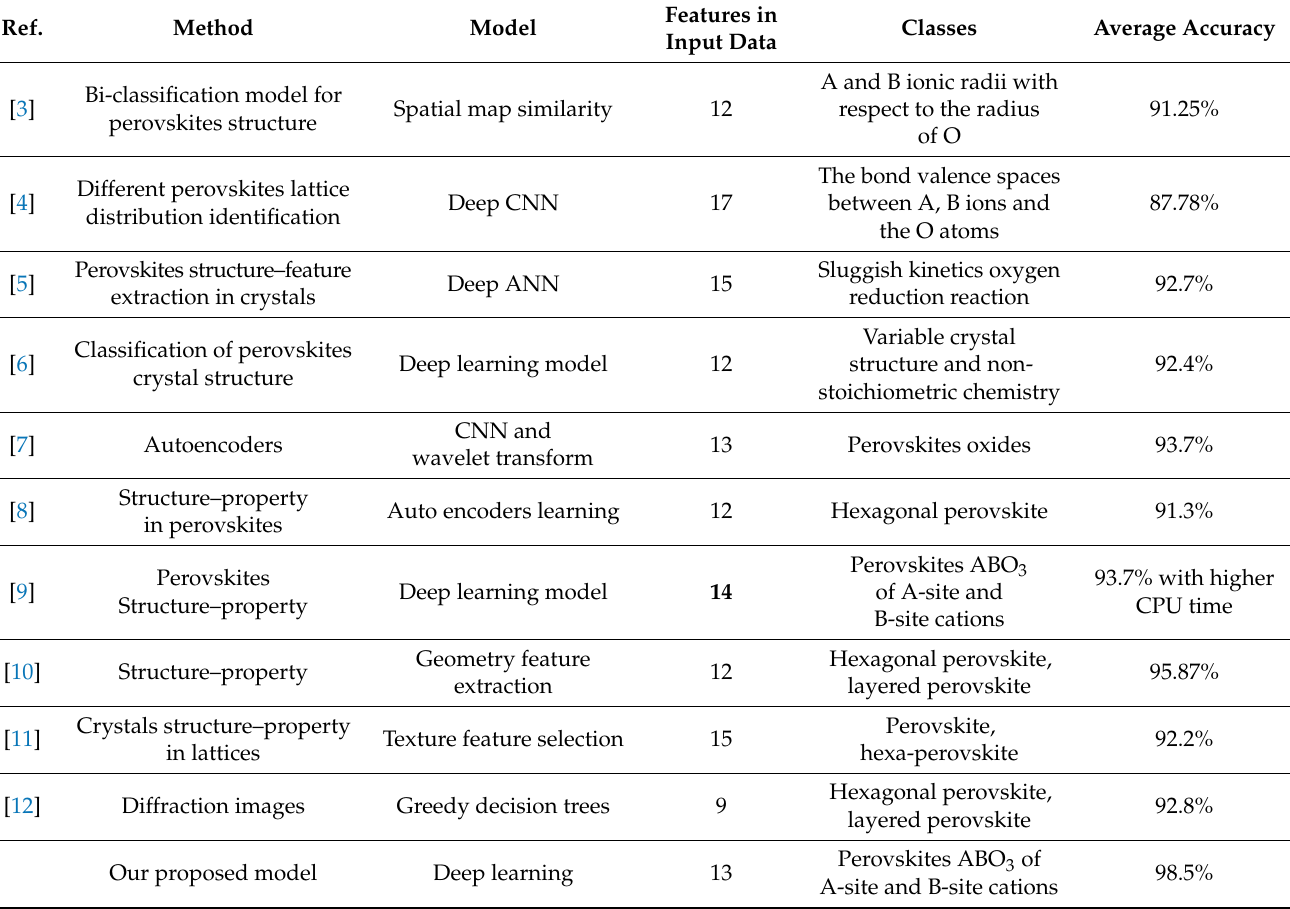
Table 1. Recent research in perovskites’ performance prediction using deep learning